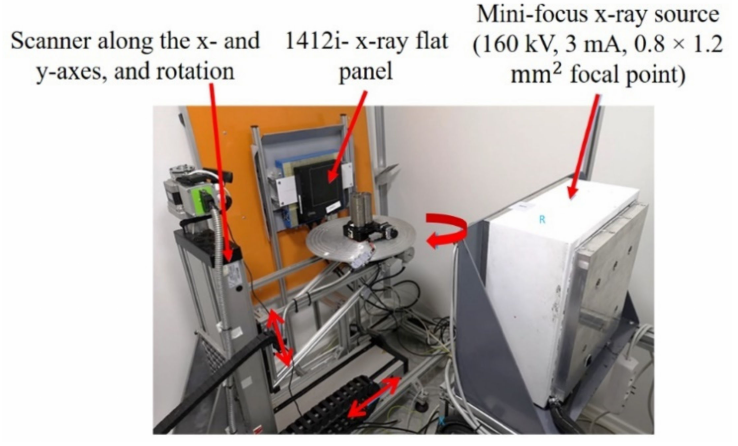
Figure 3. Mini-focus X-ray equipment for radiographic analyses.